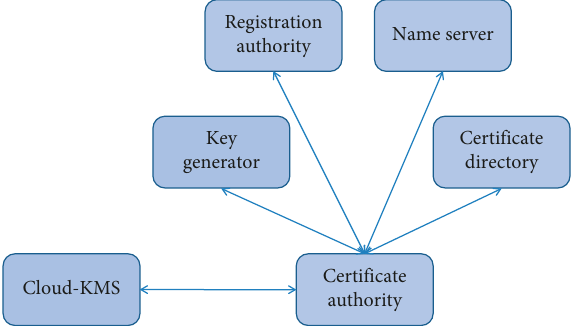
Figure 3: Services related to certificate authority.